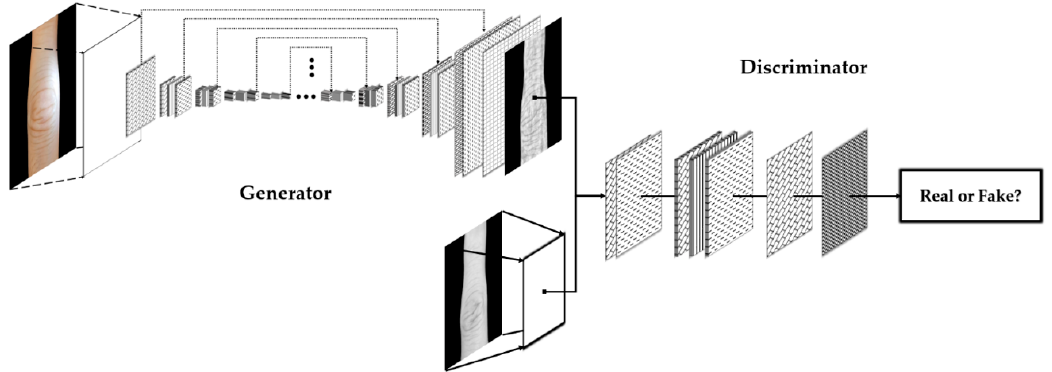
Figure 3. The architecture of CGANs used for this study (see [43] for more